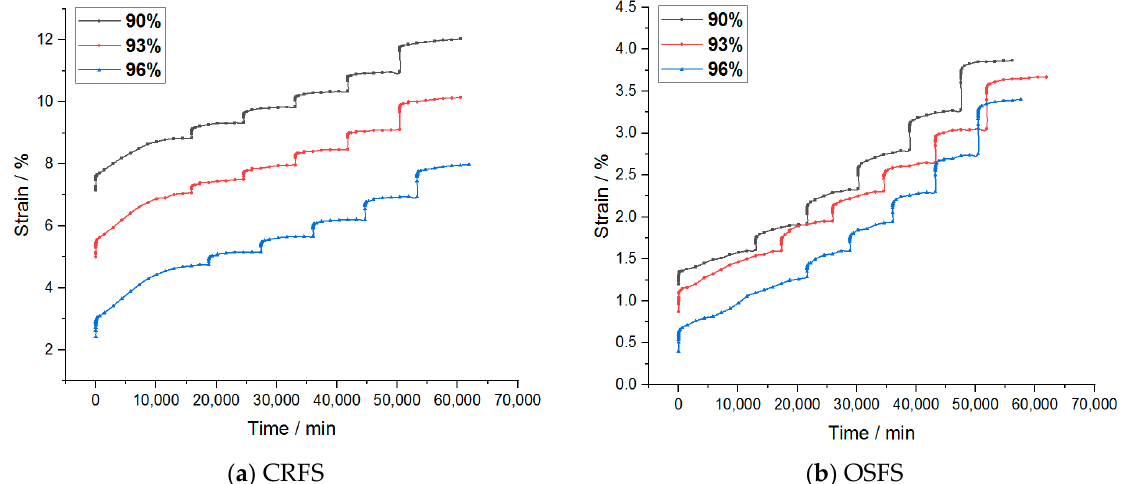
Figure 4. Strain–time curves of samples with different compaction